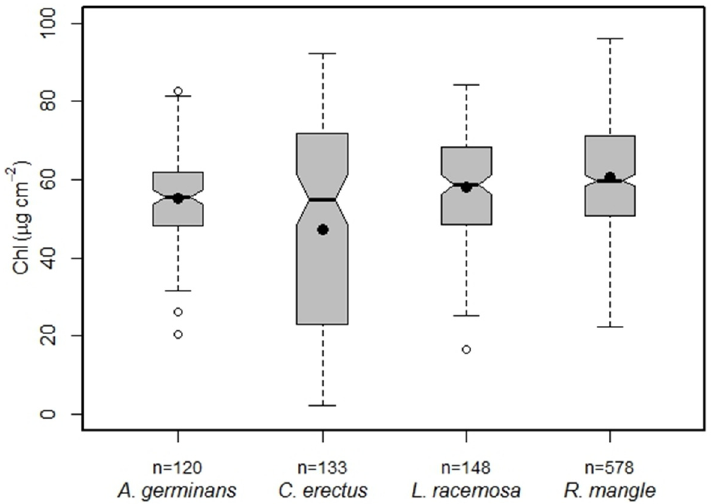
Figure 4. Leaf CC ( μ g·cm − 2 ) for the four mangrove species. Each box embodies the first and the third quartile. The bold line represents the median while the dark dot represents the mean. Whiskers are located at 1.5 times the interquartile range and white dots denote